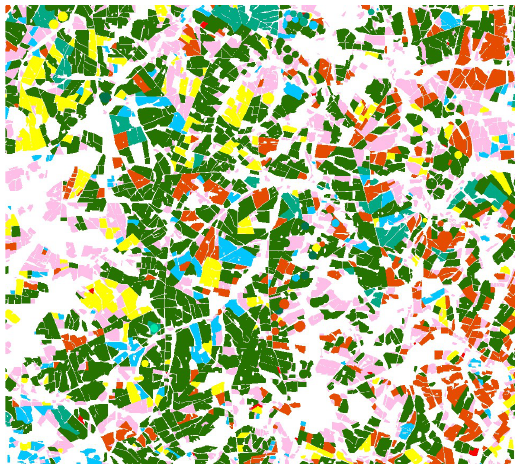
Figure 2. Field boundaries classified to different crop types represented by different